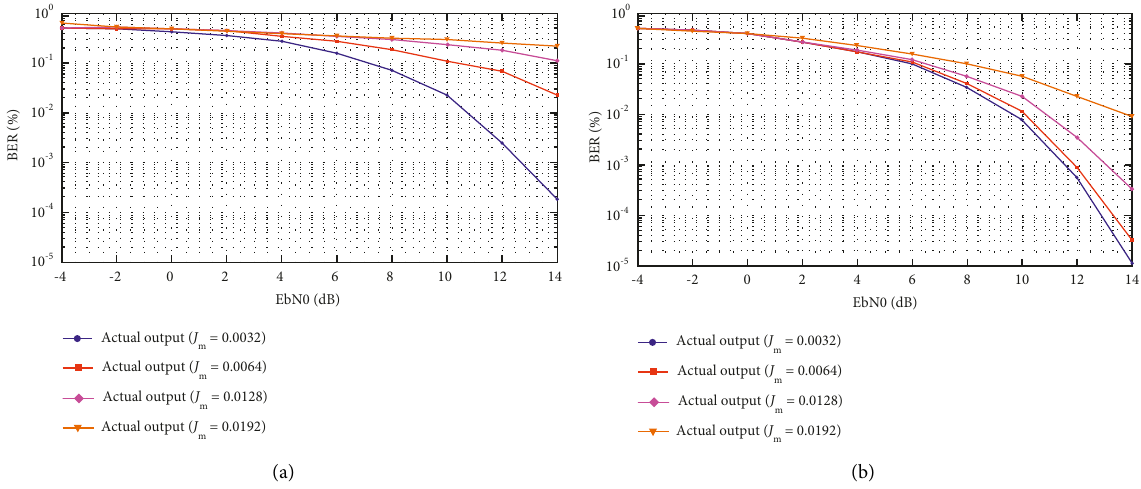
Figure 13: Simulation results of the bit error rate with noncoherent demodulation (a) R